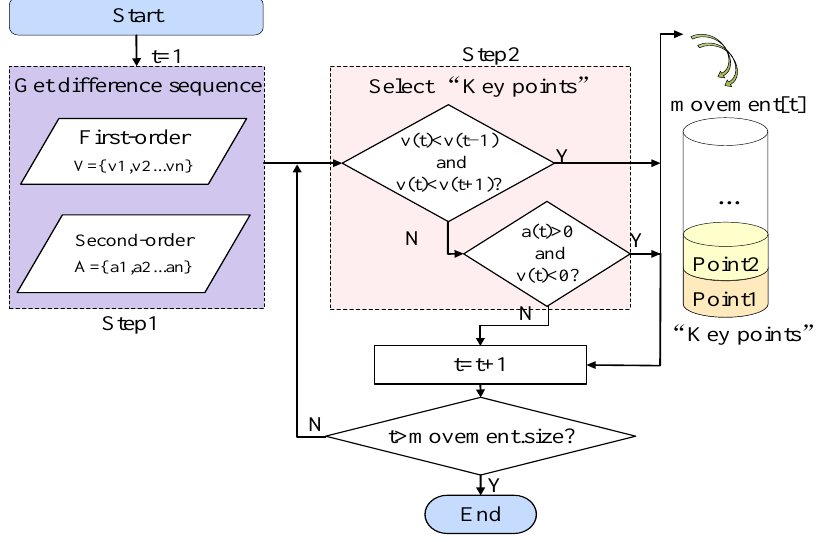
Figure 2. Flow chart of DDM method.